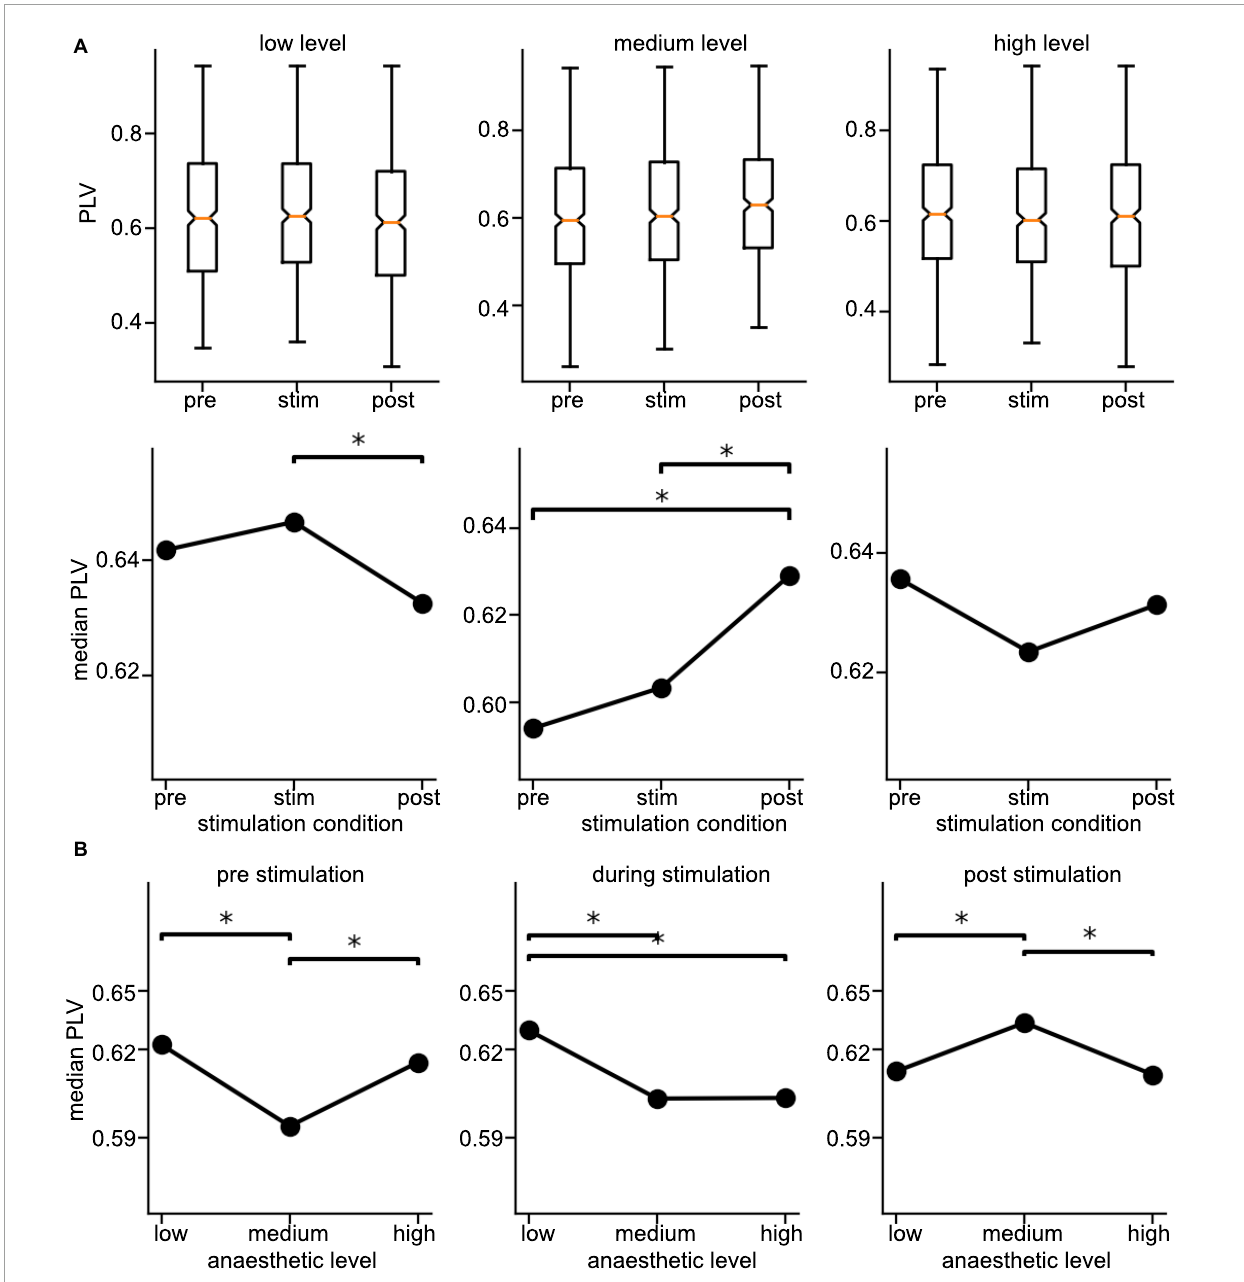
FIGURE7 Distribution of Phase Locking Values (PLVs) and their significantly different median values in the γ -frequency band. (A) Box plots of PLVs (top panels) and their median values (bottom panels). *Statistically different median values between stimulation conditions are indicated by horizontal starred brackets. (B) Statistically different medians between anesthetic levels are indicated by horizontal starred brackets. PLV values were taken from channel clusters C2 and C3, significance level was α = 0.05 with Mann–Whitney U-test based on data pooled over all